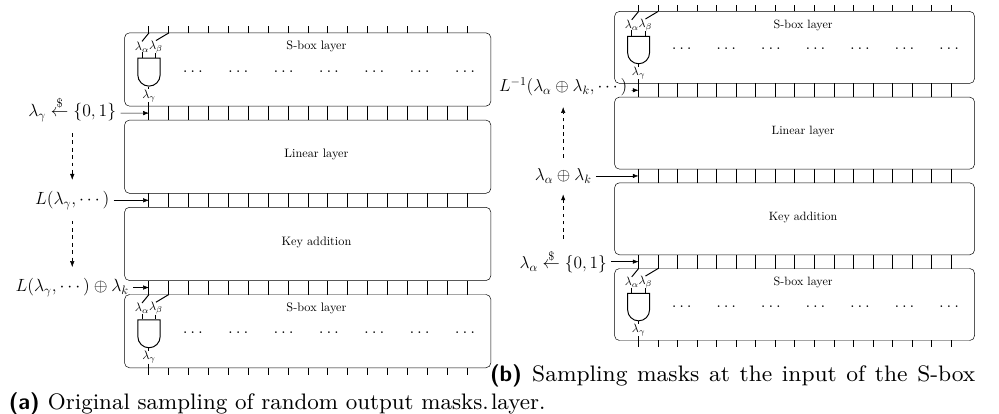
Figure 3: Changes for the sampling of random masks λ γ